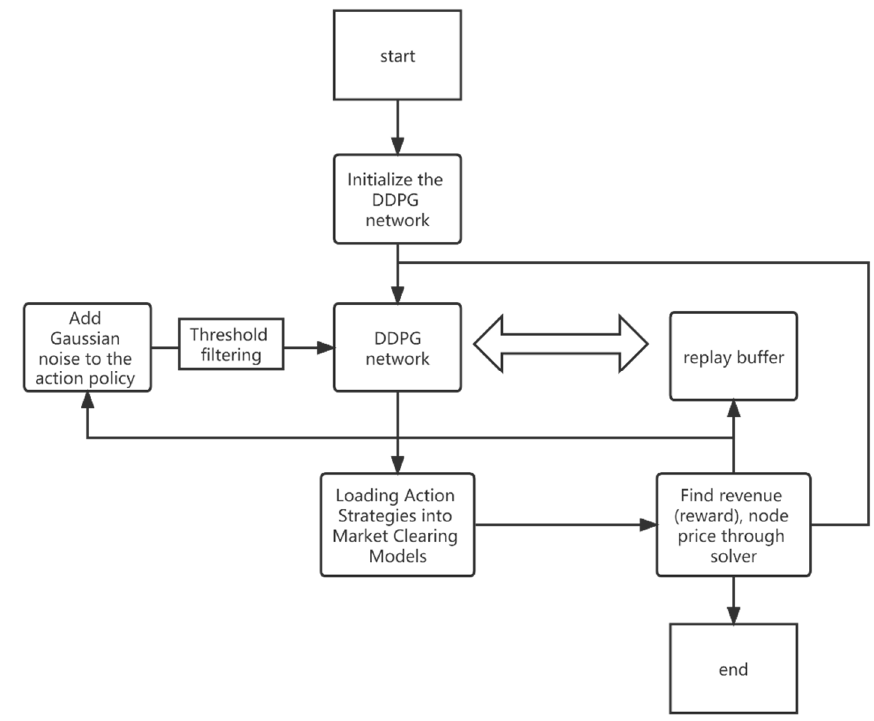
Figure 3. The overall flow chart of the algorithm.